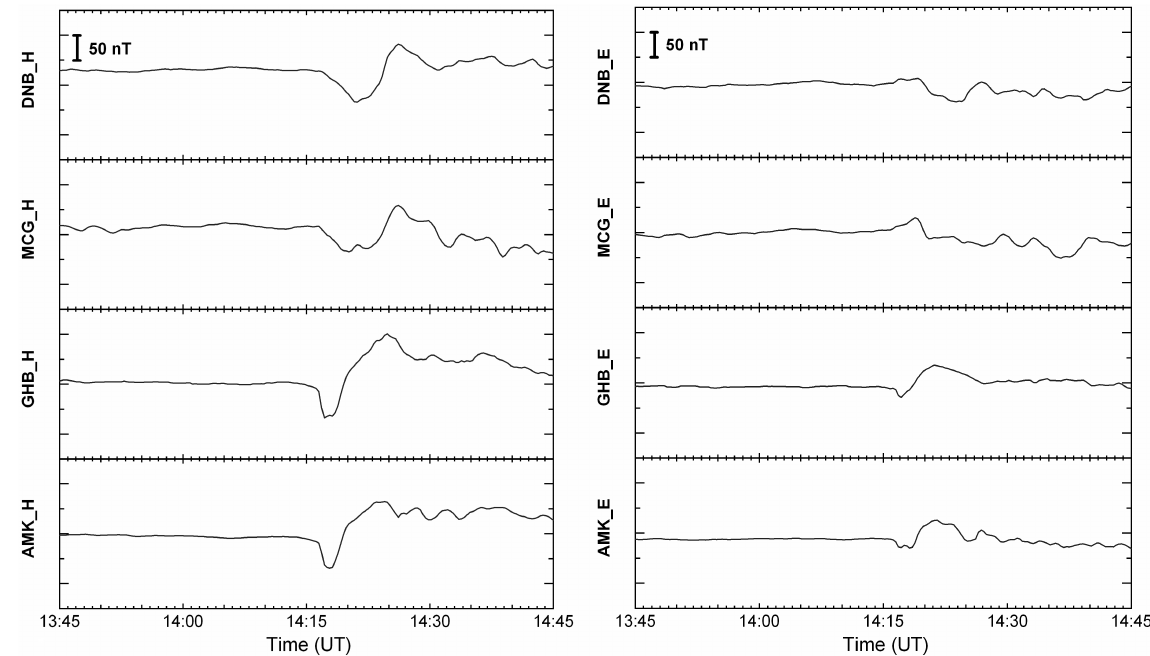
Fig. 5. High latitude magnetograms from the DMI and MAGIC Greenland chains (afternoon MLT), on 6 January 1998 between 13:45 and 14:45UT. On the left side the North-South component ( H ) is shown, while on the right side one can see the East-West component ( E ). The stations are displayed in decreasing order of magnetic latitude from the northernmost, on top (MCG – MAGIC-1 GISP , ∼ 76 . 4 ◦ MLAT), to the southernmost, on bottom (AMK – Ammassalik, ∼ 69 . 3 ◦